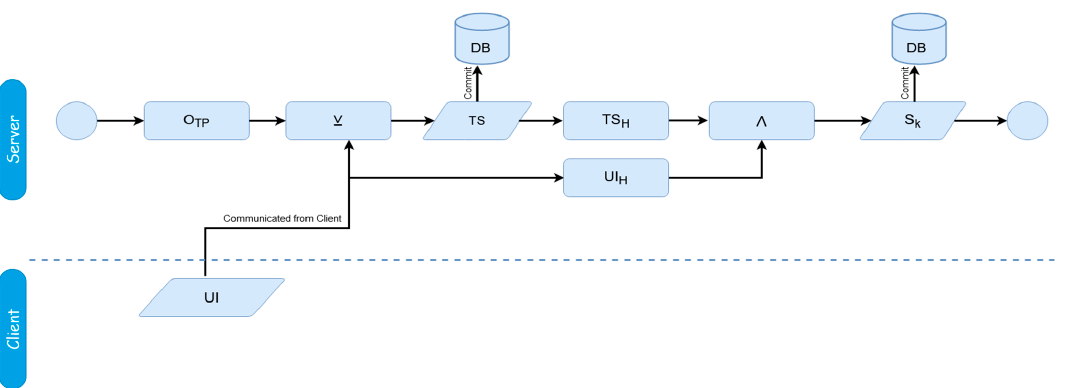
Figure 2. Registration Process Phase.